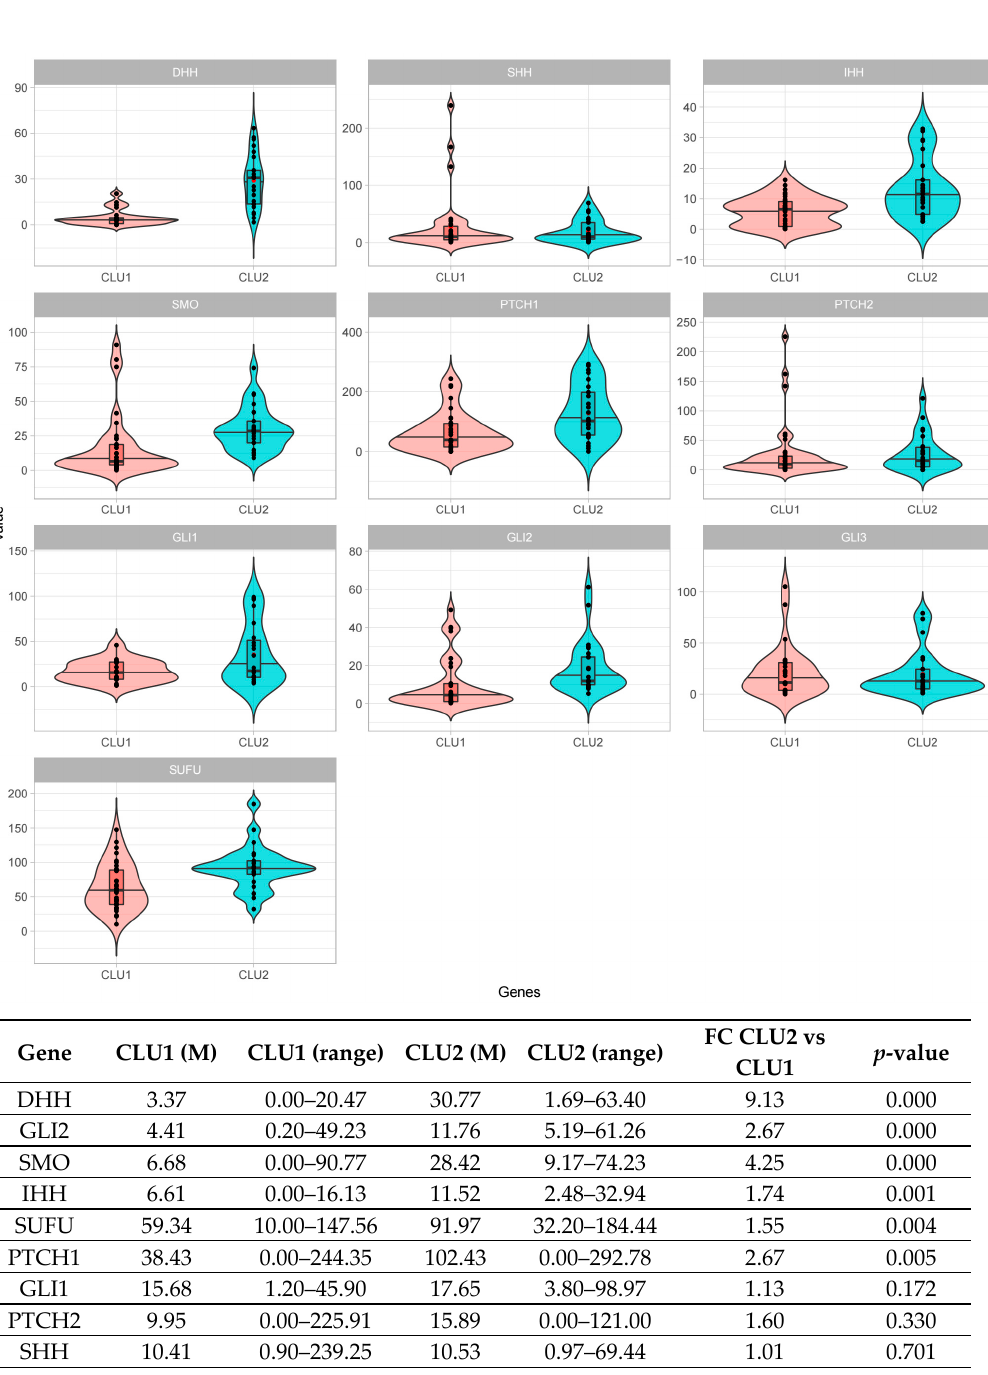
Figure 4. Digital PCR validation of the 10 HH genes signature across the retrospective NDMM patients’ cohort. The comparison between patients’ subgroups (Cluster 1 – CLU1 and Cluster 2 – CLU2) stratified according to the 10 HH gene signature effectively results in an upregulation of the pathway in Cluster 2 compared to Cluster 1, as detected by the digital PCR assays (6/10 genes p<.05). Genes are illustrated according to their role in the pathway: SHH, DHH, and IHH (the ligands); PTCH1, PTCH2, and SMO (the receptors); SUFU (pathways’ intermediate); and GLI1, GLI2, and GLI3 (the transcription factors).